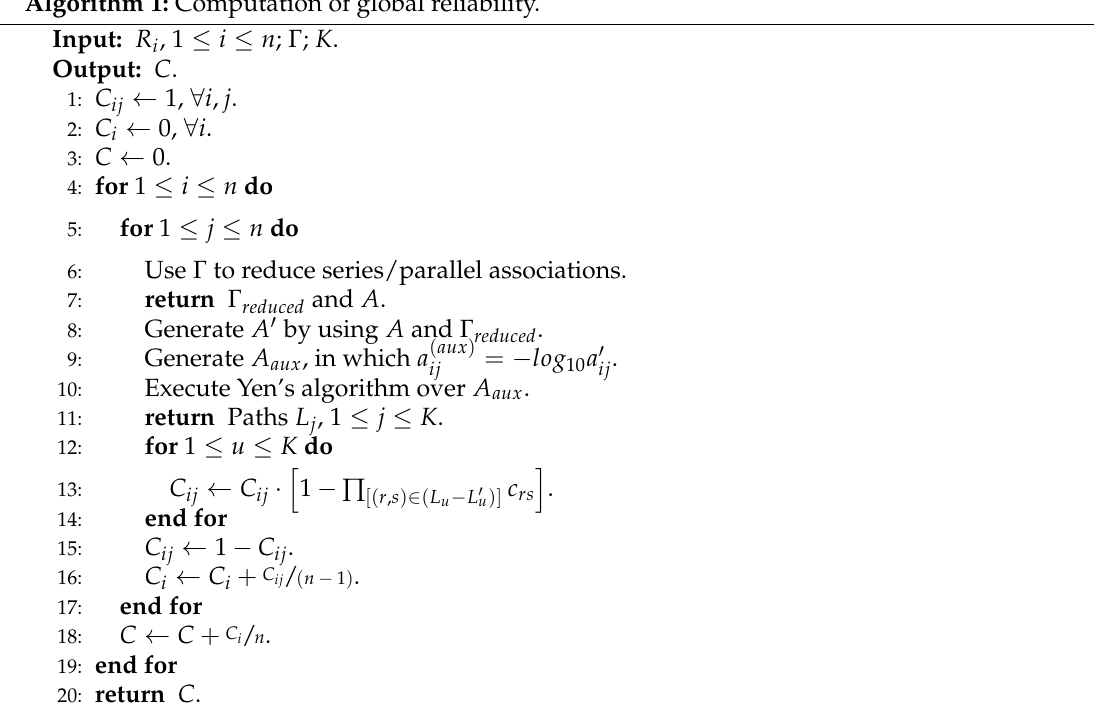
Algorithm 1: Computation of global